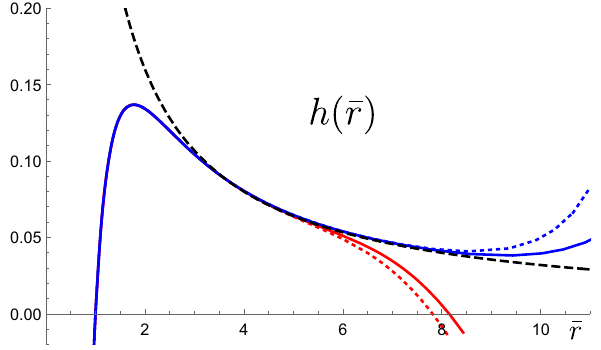
Fig. 4 Function h ( ¯ r ) for b = 1 . 575812(abluedottedcurve),1 . 575811 (blue), 1 . 5757 (red), and 1 . 5756 (red dotted) and the general relativistic solution h ( ¯ r ) = 2 ˜ m / ¯ r for 2 ˜ m =0.32 (black dashed) for values (cid:9) = 0, (cid:2) = 0, r = − 1, k = 1 / 2, c = − 1, a = 1 (note that, in this gauge, h 0 0 h (cid:3)= f asymptotically). Fine-tuning is done using the first 100 terms